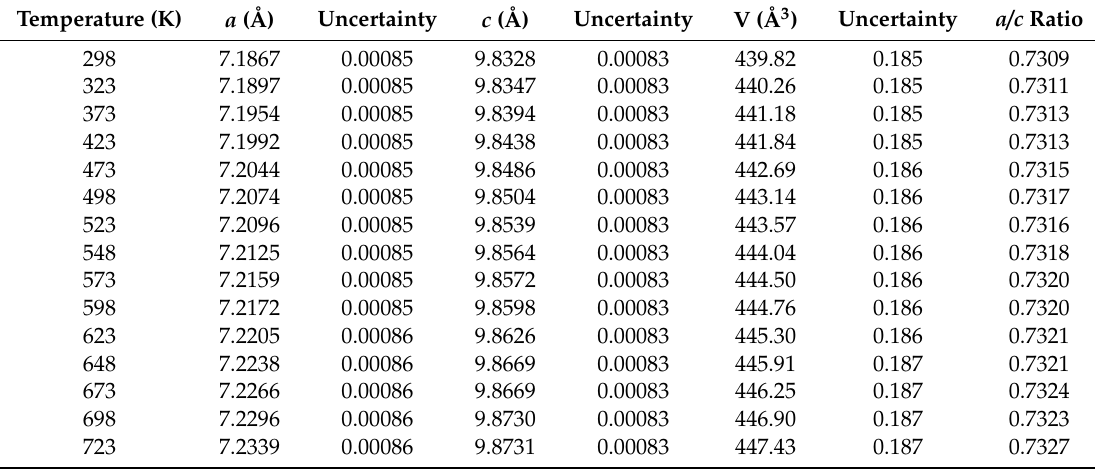
Table 1. Measured lattice parameters and volume for bastnäsite-(La) from 298 to 723 K. Temperature (K)